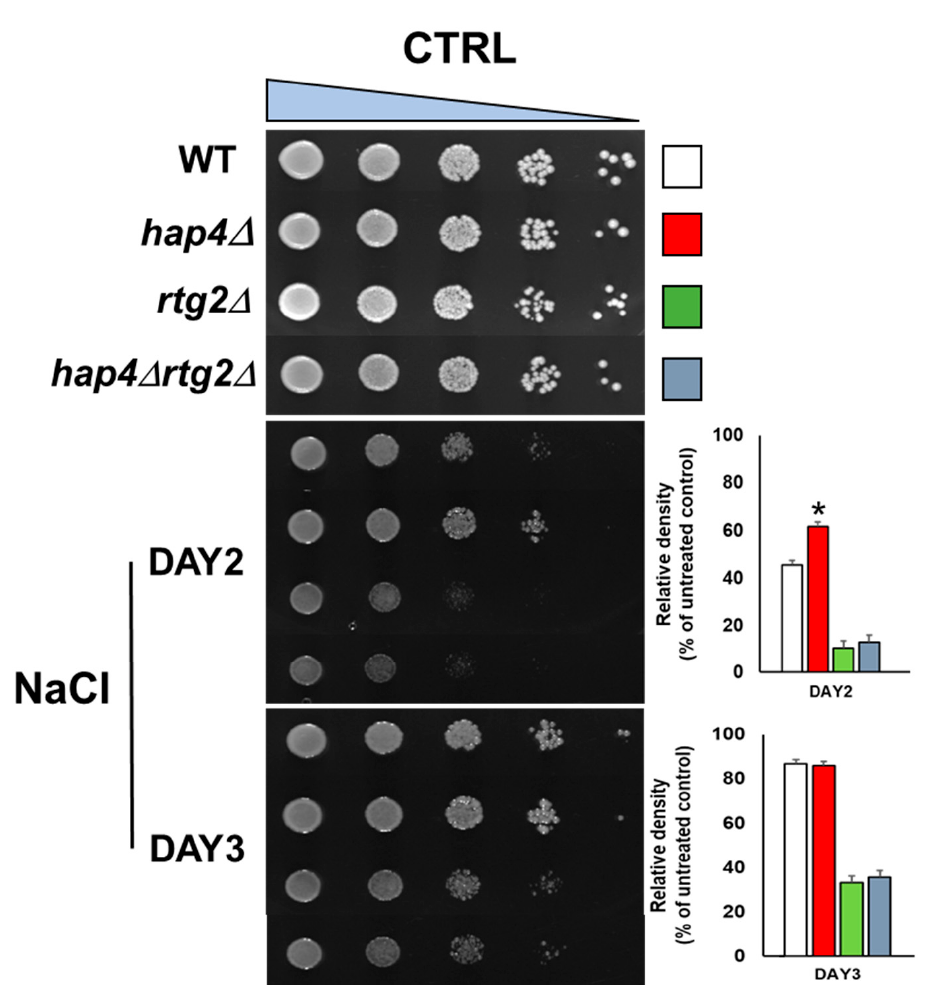
Figure 1. Sensitivity of wild type and mutant cells to sodium chloride. Wild type (WT) and mutant cells, lacking HAP4 (hap4 ∆ ), RTG2 (rtg2 ∆ ), or HAP4 and RTG2 (hap4 ∆ rtg2 ∆ ), were grown overnight in YPD medium and diluted to 1 OD600, and ten-fold serial dilutions were spotted on YPD plates without (CTRL) or with 0.8 M sodium chloride (NaCl). Growth was scored after 2–3 days. Growth on plates was quantified by using a quantitative imaging-based protocol described in Petropavlovskiy et al. [22]. Data were analyzed using unpaired Student’s t -test: * p < 0.01 was considered significant when comparing wild type versus hap4 ∆ cells at day 2 from three independent experiments.